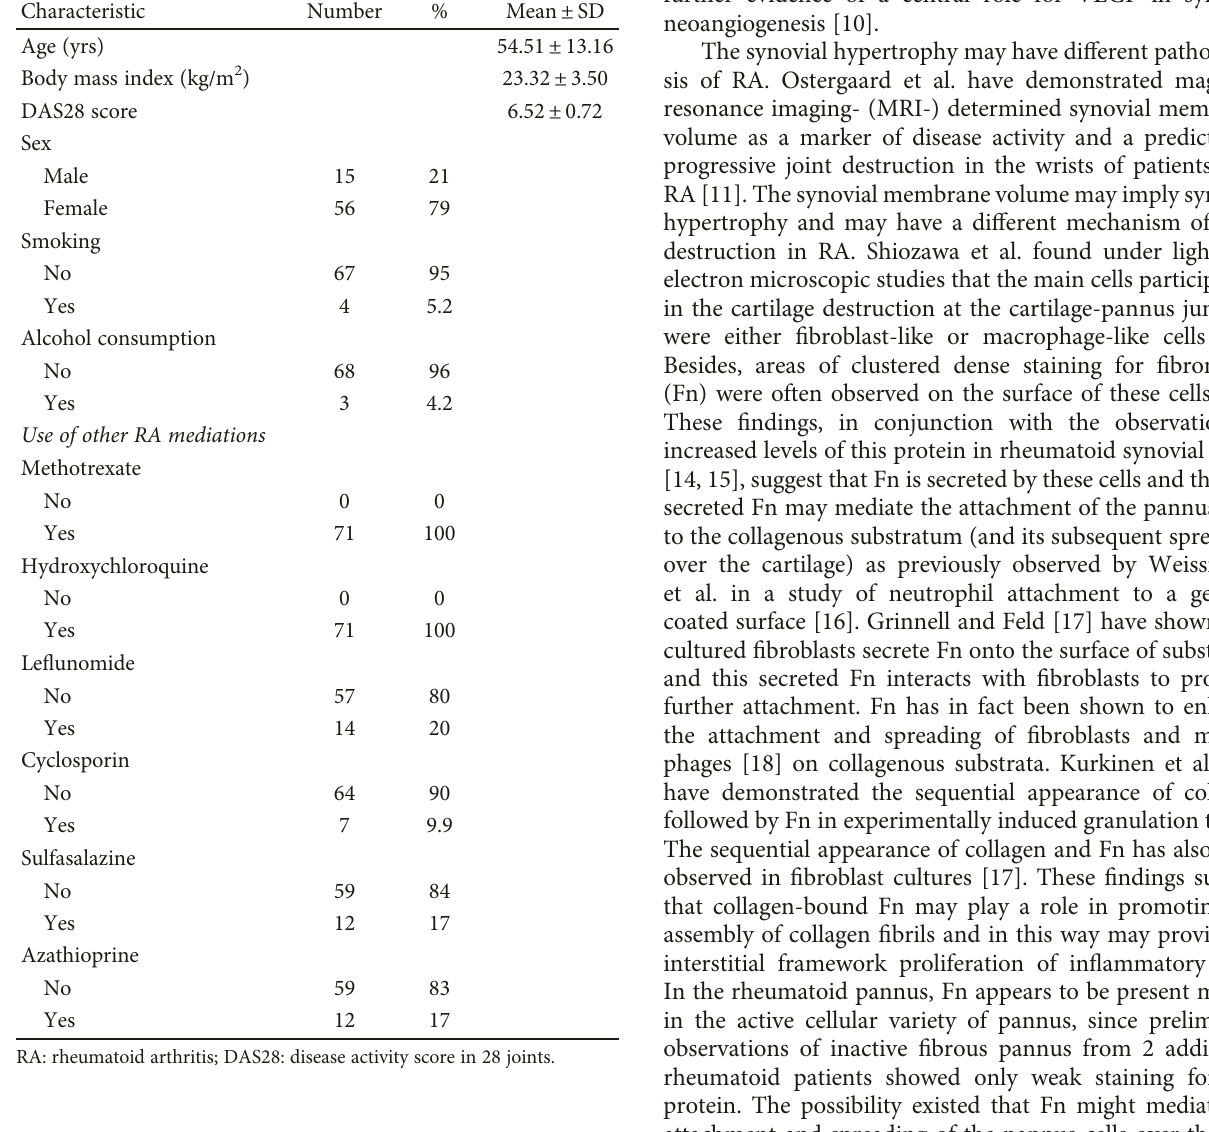
Table 1: Baseline demographic and clinical characteristics of patients with rheumatoid arthritis who received anti-TNF-alpha- adalimumab